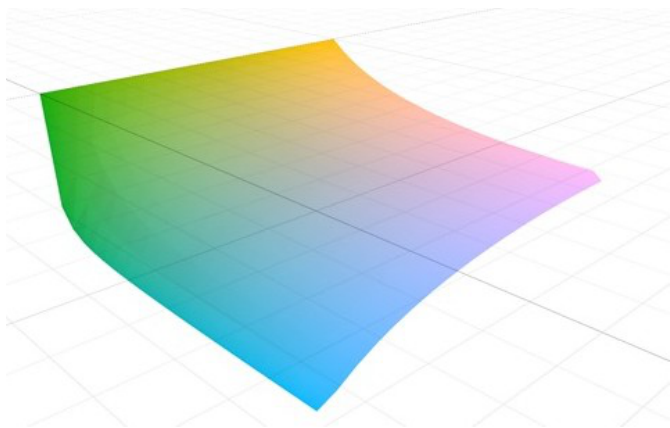
Figure 17. Anger + Fear—conscientiousness factor.